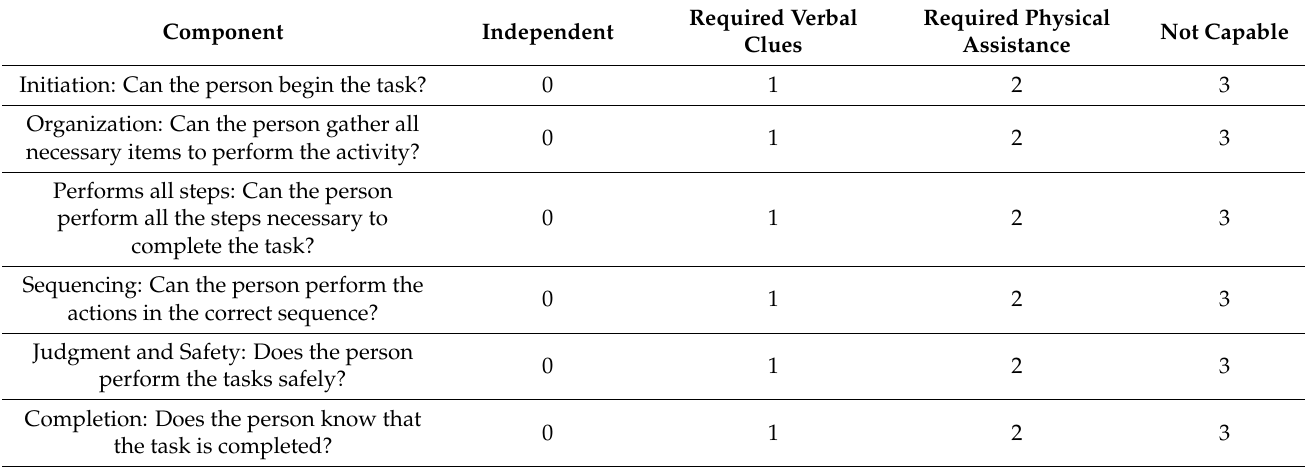
Table 1. The KTA functional test with the scoring